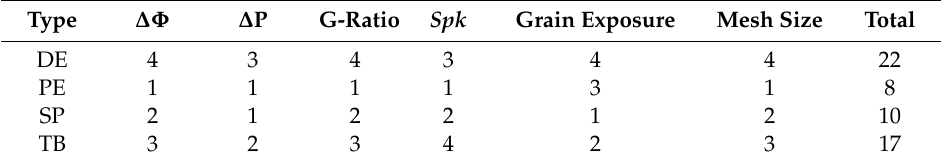
Table 3. Numerical qualification of the various discs tested, for the characteristics evaluated. Type ∆Φ ∆ P G-Ratio Spk Grain Exposure Mesh Size